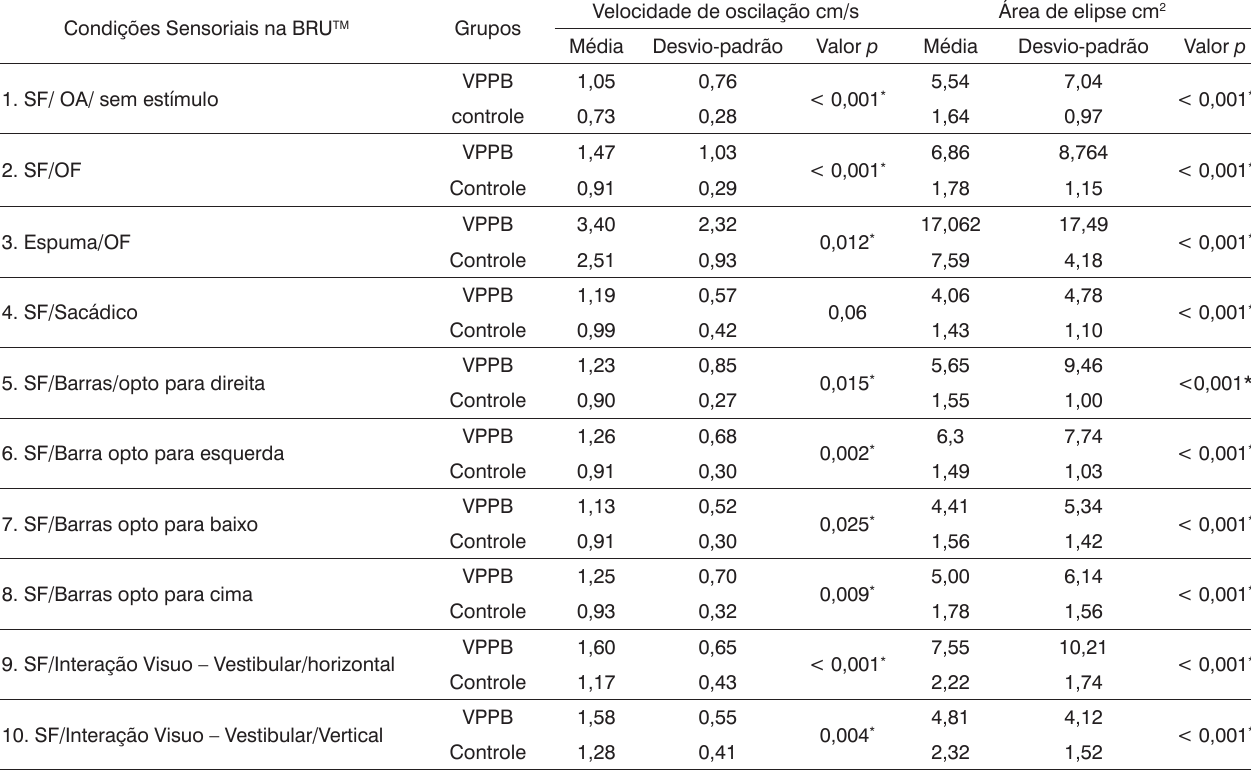
Tabela 2. Valores de médias, de desvio padrão e p -valores da velocidade de oscilação e área de elipse nas dez condições em pacientes com VPPB e grupo